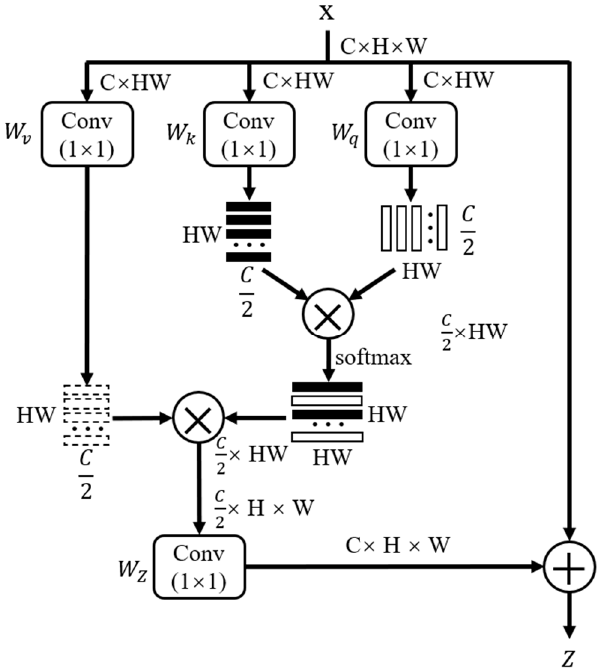
Figure 3. The structure of a non-local